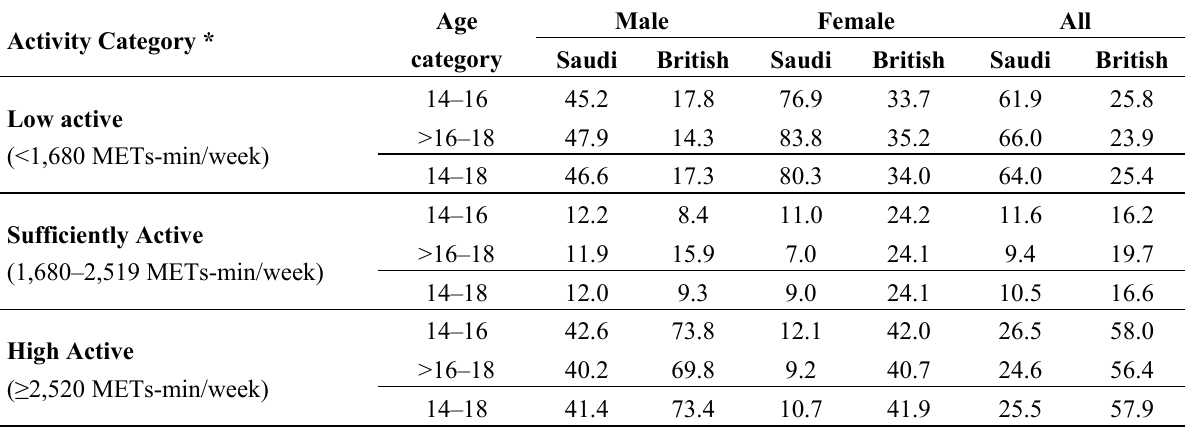
Table 3. Proportions (%) of Saudi and British adolescents classified as low active, sufficiently active and high